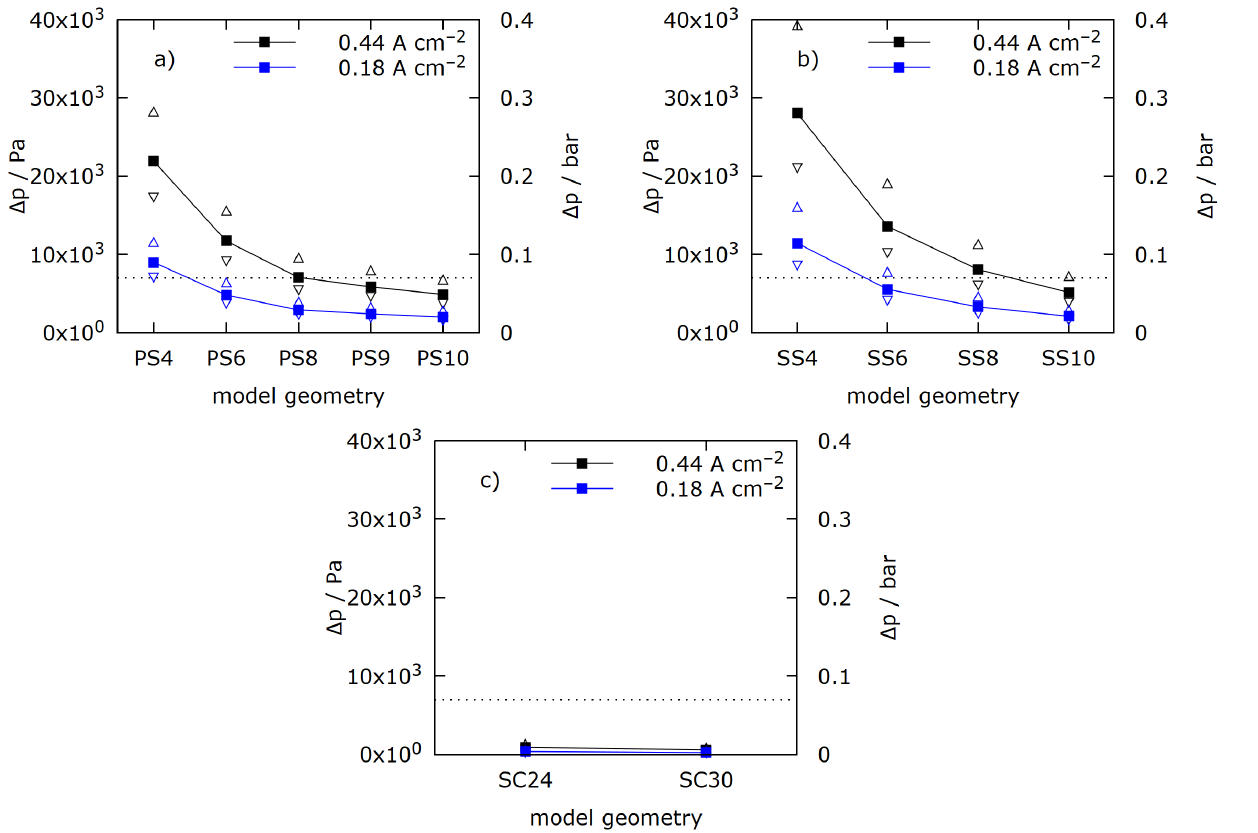
Figure 11. Pressure difference for the anode flow fields. (cid:52) / (cid:53) show results for a variation of ± 0.05mm in channel depth. ( a ) parallel serpentine; ( b ) separate serpentine; ( c ) straight channels; dotted line at target value of 0.07